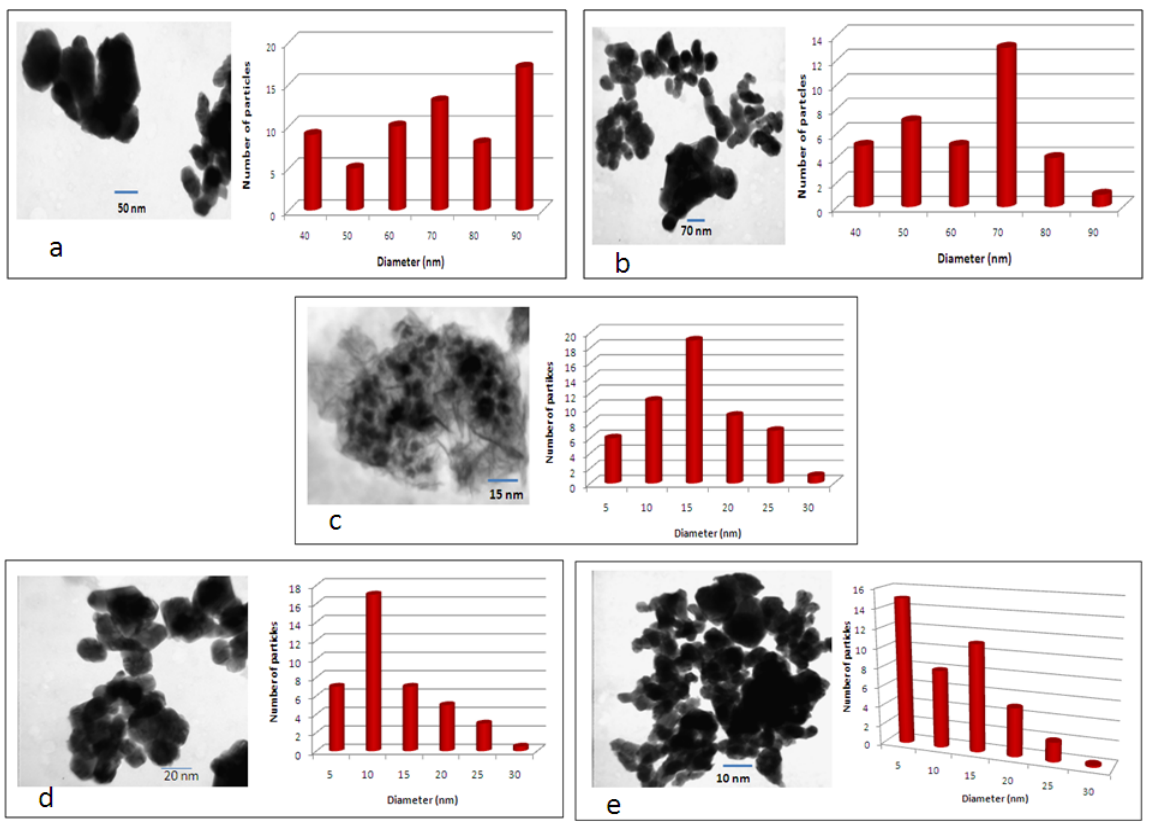
Figure 3. TEM image and particle size distribution of ( a ) zeolite, ( b ) sand, ( c ) fibreglass, ( d ) anion resin, and ( e ) cation resin coated with silver